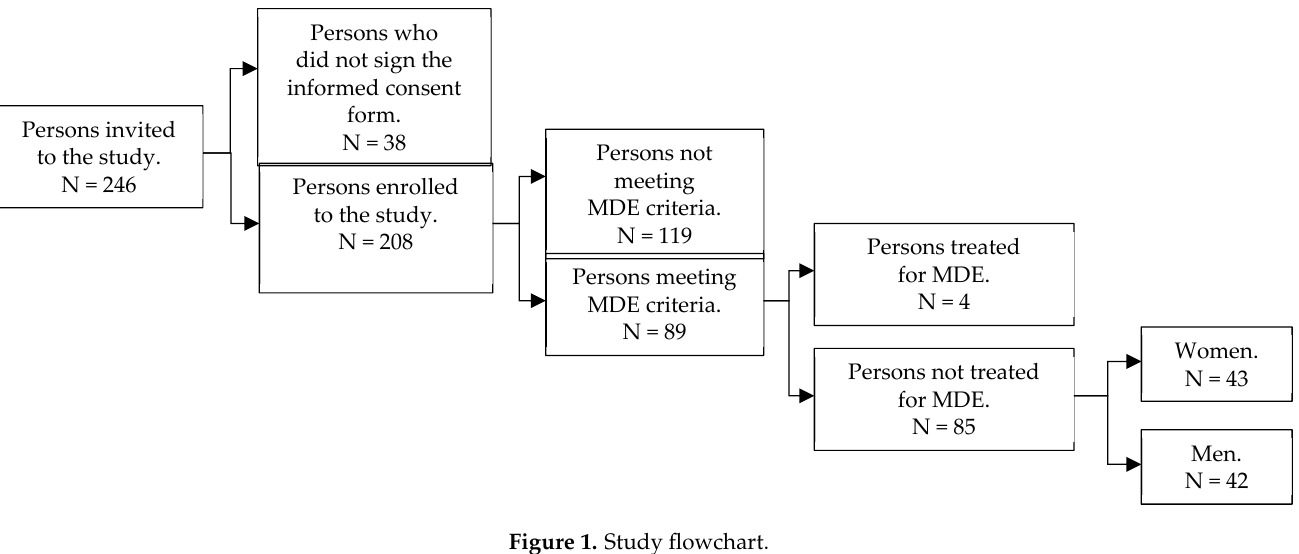
Figure 1. Study flowchart. Table 1. Demographic and clinical characteristics of dialysis patients with untreated MDE (N = 85).